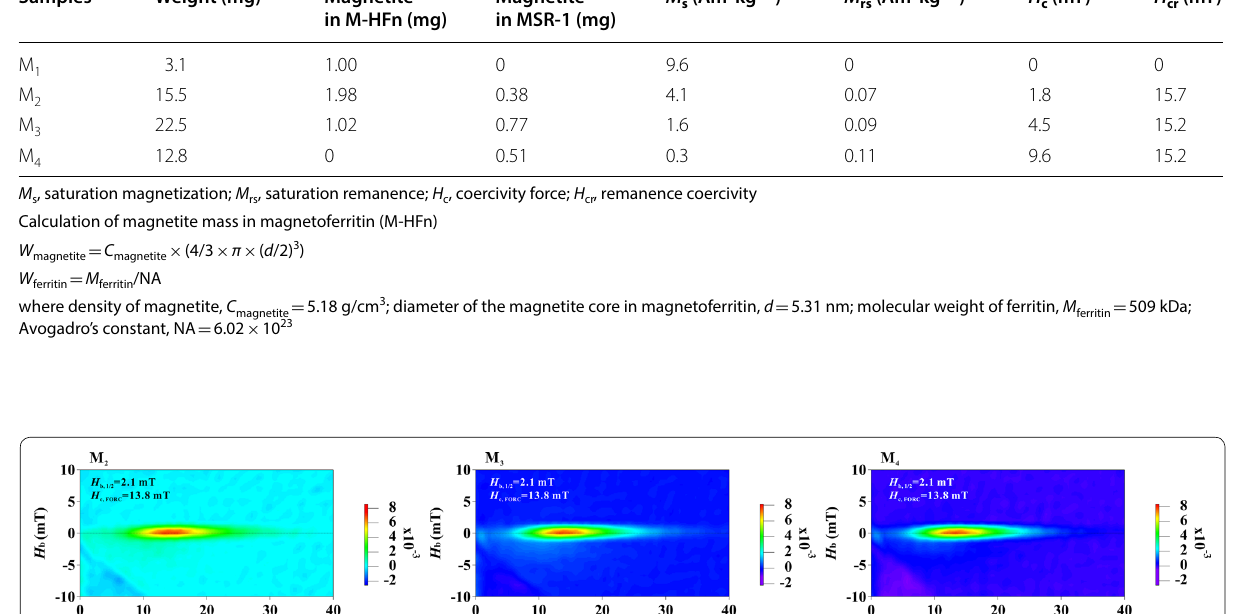
Table 1 Hysteresis parameters obtained from room-temperature measurements